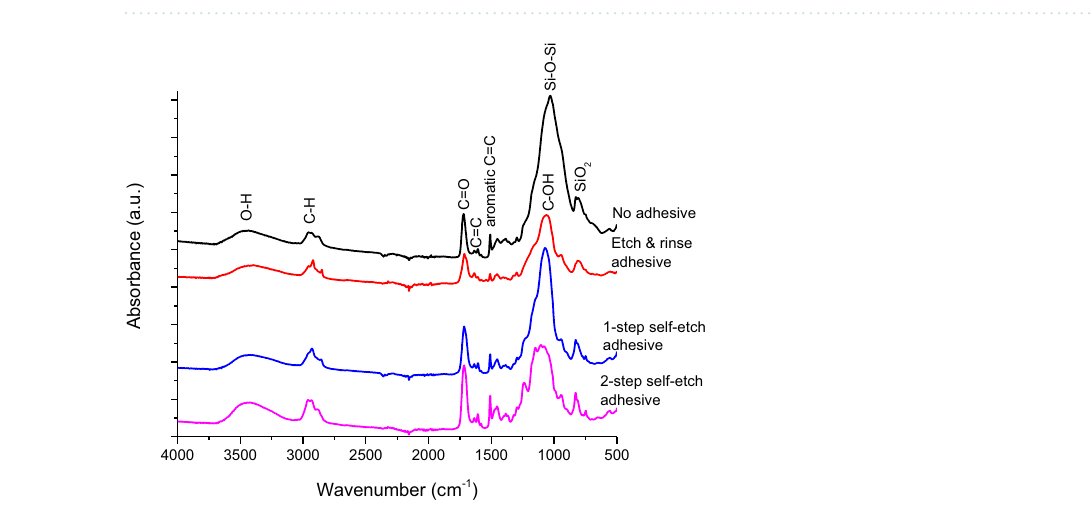
Figure 9. Representative Fourier-transform infrared spectra of uncoated restorative material surface before 32 days lactic acid immersion.